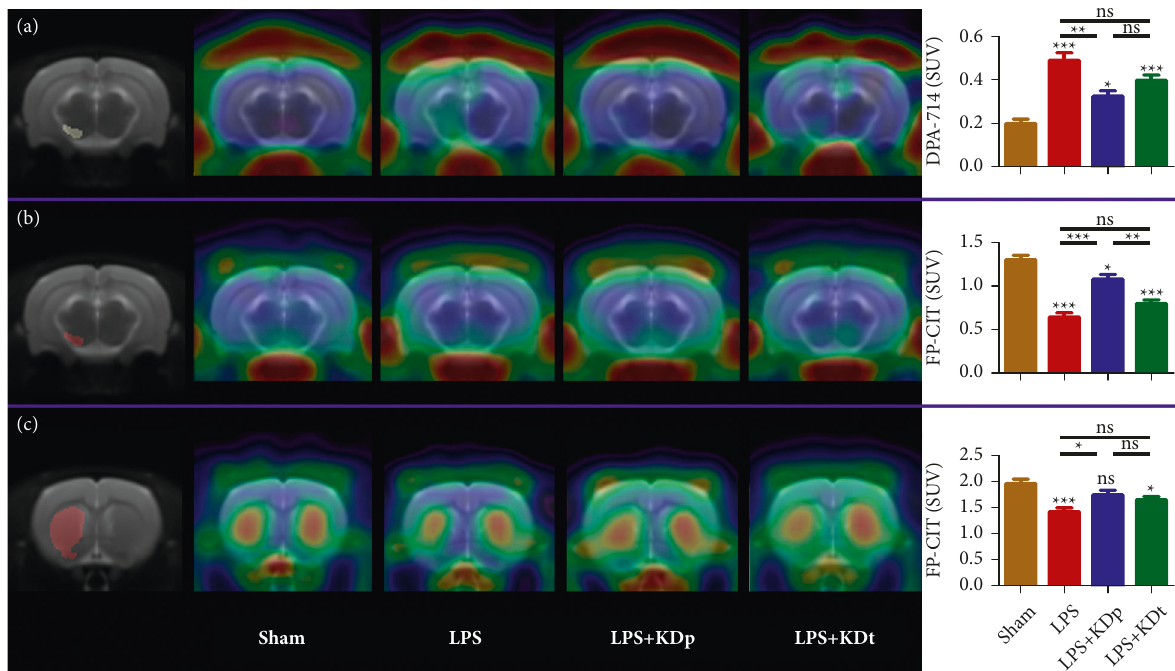
Figure 2: Brain TSPO and DAT PET imaging using 18 F-DPA-714 and 18 F-FP-CIT. The SUVs of 18 F-DPA-714 (a) and 18 F-FP-CIT (b) in substantia nigra, and those of 18 F-FP-CIT in striatum (c) were compared among different groups. Data were presented as the mean ± SEM. ∗∗∗ P < 0 . 001; ∗∗ P < 0 . 01; ∗ P < 0 . 05; LPS, lipopolysaccharide; KDp, preventive intervention with KD prior to the PD onset; KDt, therapeutic intervention with KD after the PD